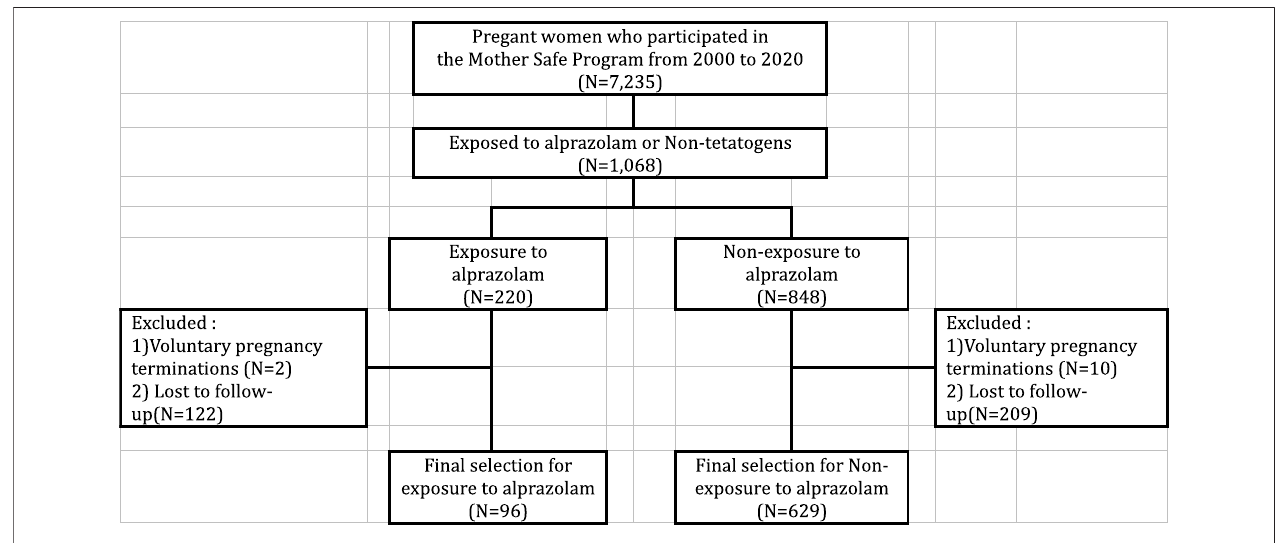
FIGURE 1 | Selection of study participants.